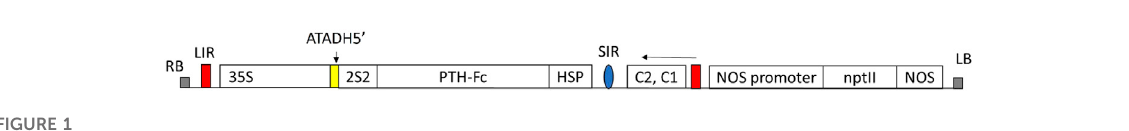
FIGURE 1 ThegeneconstructfortransientPTH-Fcexpressionin Nicotianabenthamiana .RB/LB:rightborder/leftborder;LIR:longintergenicregion;35S: Cauli fl owermosaicvirus35Spromoter;ATADH5 ’ :5 ′ UTRofthe Arabidopsisthaliana alcoholdehydrogenasegenefortranslationenhancement;2S2: secretorysignalpeptide;PTH-Fc:PTH-Fccodingsequence;HSP: Arabidopsisthaliana HSP18.2terminator;SIR:shortintergenicregion;C1,C2:Rep/ RepA coding sequence; NOS promoter/NOS: nopaline synthase promoter/terminator. nptII: gene codes for an aminoglycoside phosphotransferase II conferring resistance to kanamycin for stable transgenic line selection (if